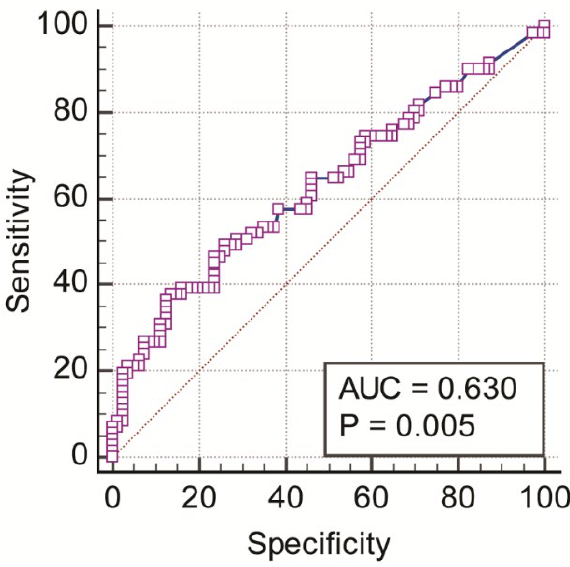
Figure 5. ROC curve for mean pitch discrimination threshold (cents).